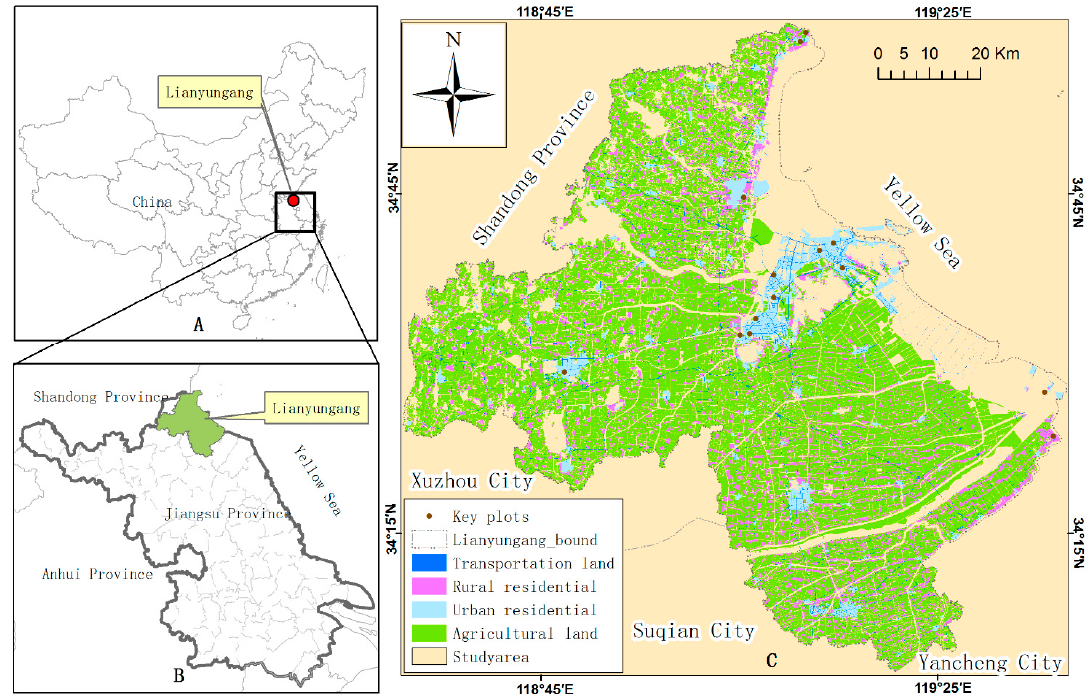
Figure 2. The location of Lianyungang ( A , B ) and its land-use map of 2010 ( C ). This map highlights the major land-use types and key plots emitting airborne pollutants in the study area.